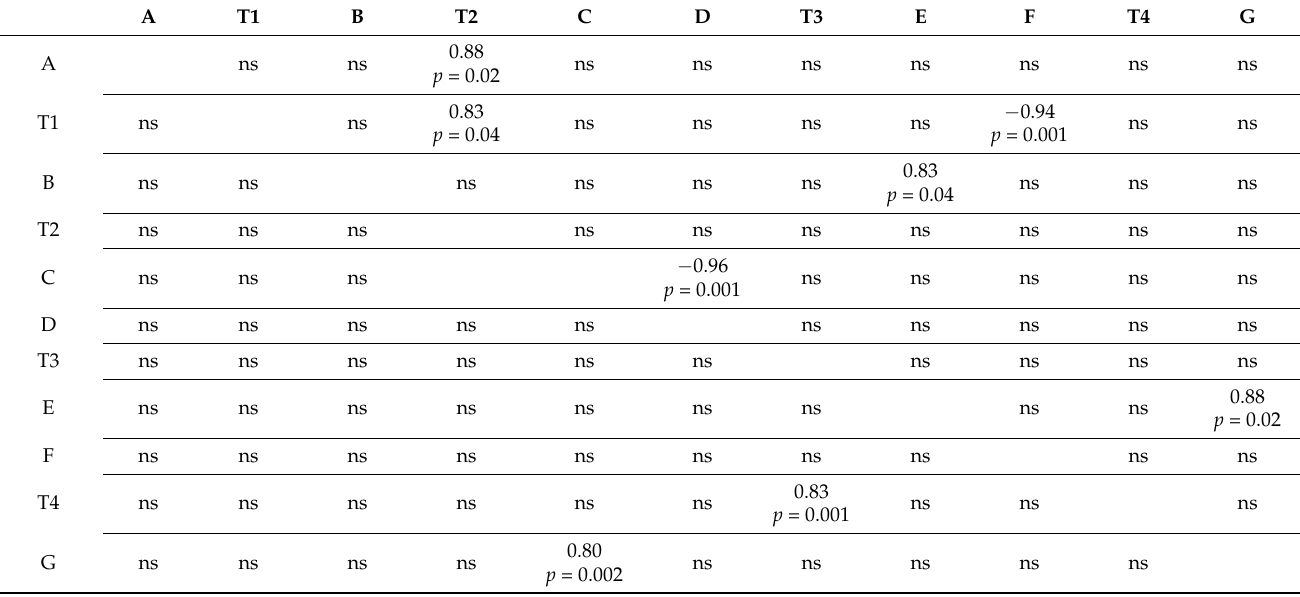
Table 4. Spearman R correlation coefficient and p value for number of qualifications; above—1 start; below—2 and more